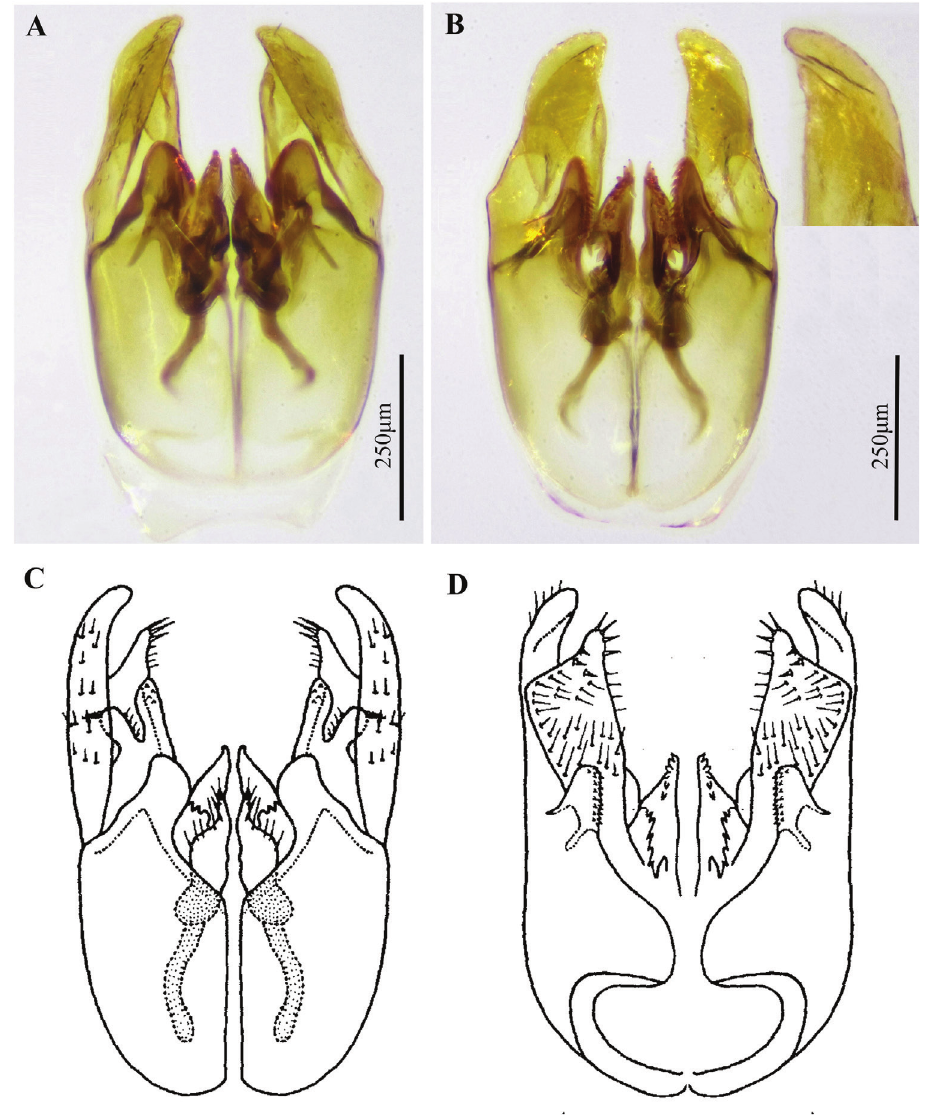
Figure 35. Male genitalia A, B Pseudophotopsis subaurea sp. nov., dorsal and ventral views, respectively C, D P . binghami Bischoff, dorsal and ventral views, respectively (modified from Lelej (1985)).